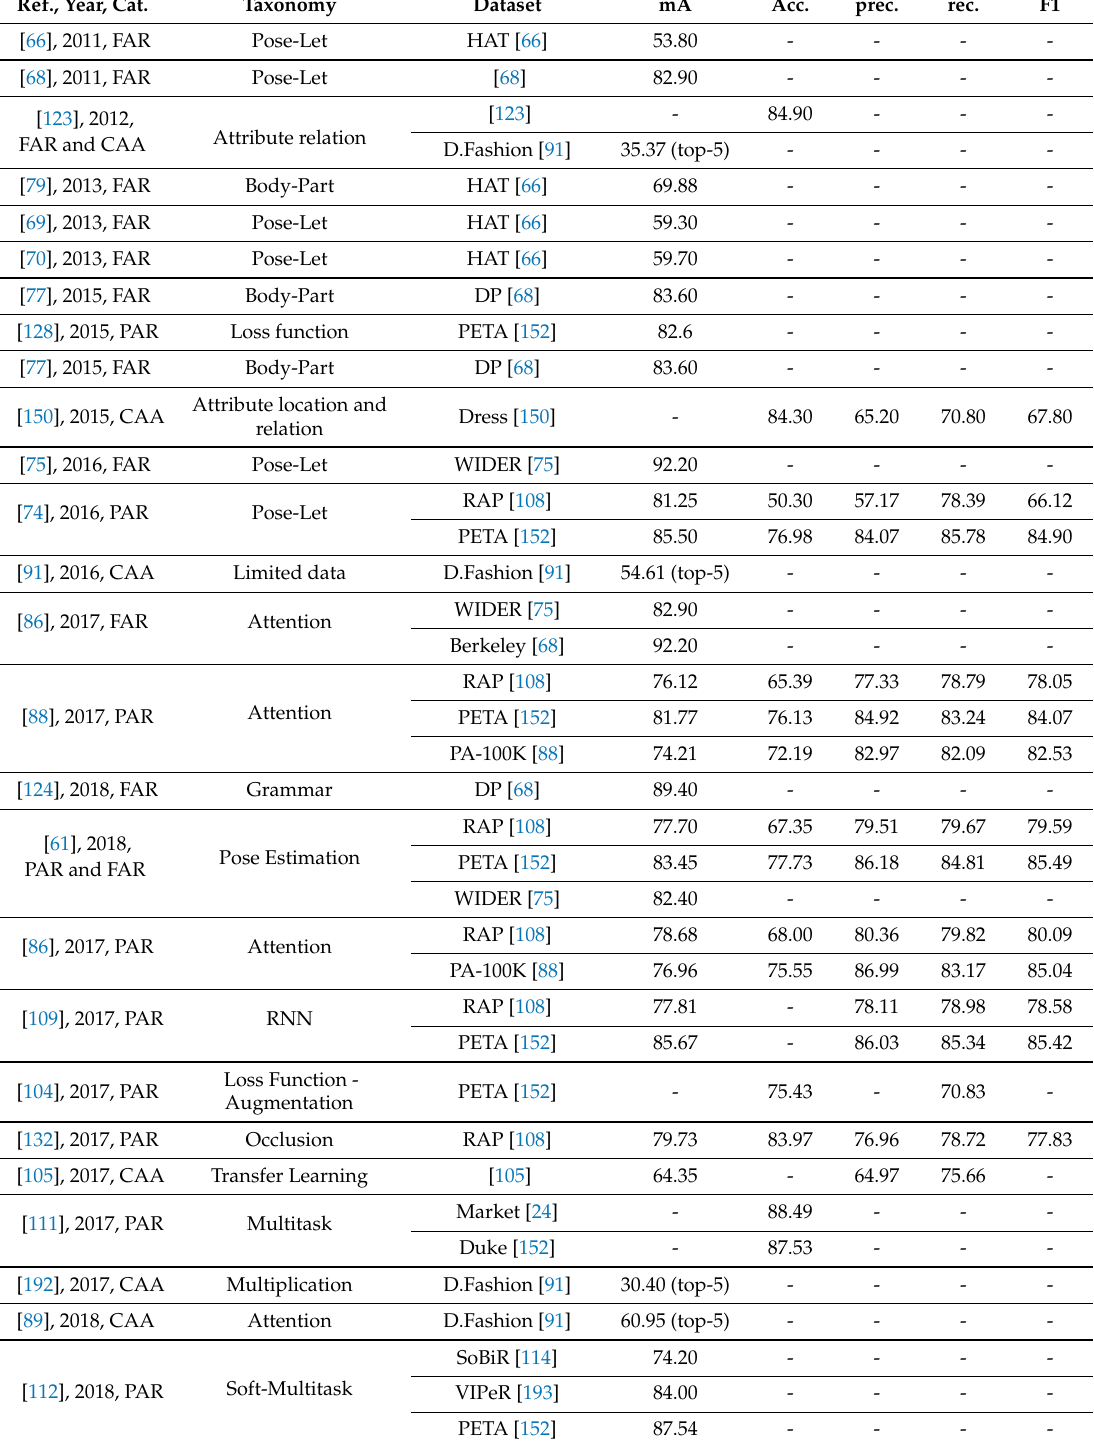
Table 2. Performance comparison of HAR approaches over the last decade for different benchmarks. Ref., Year,